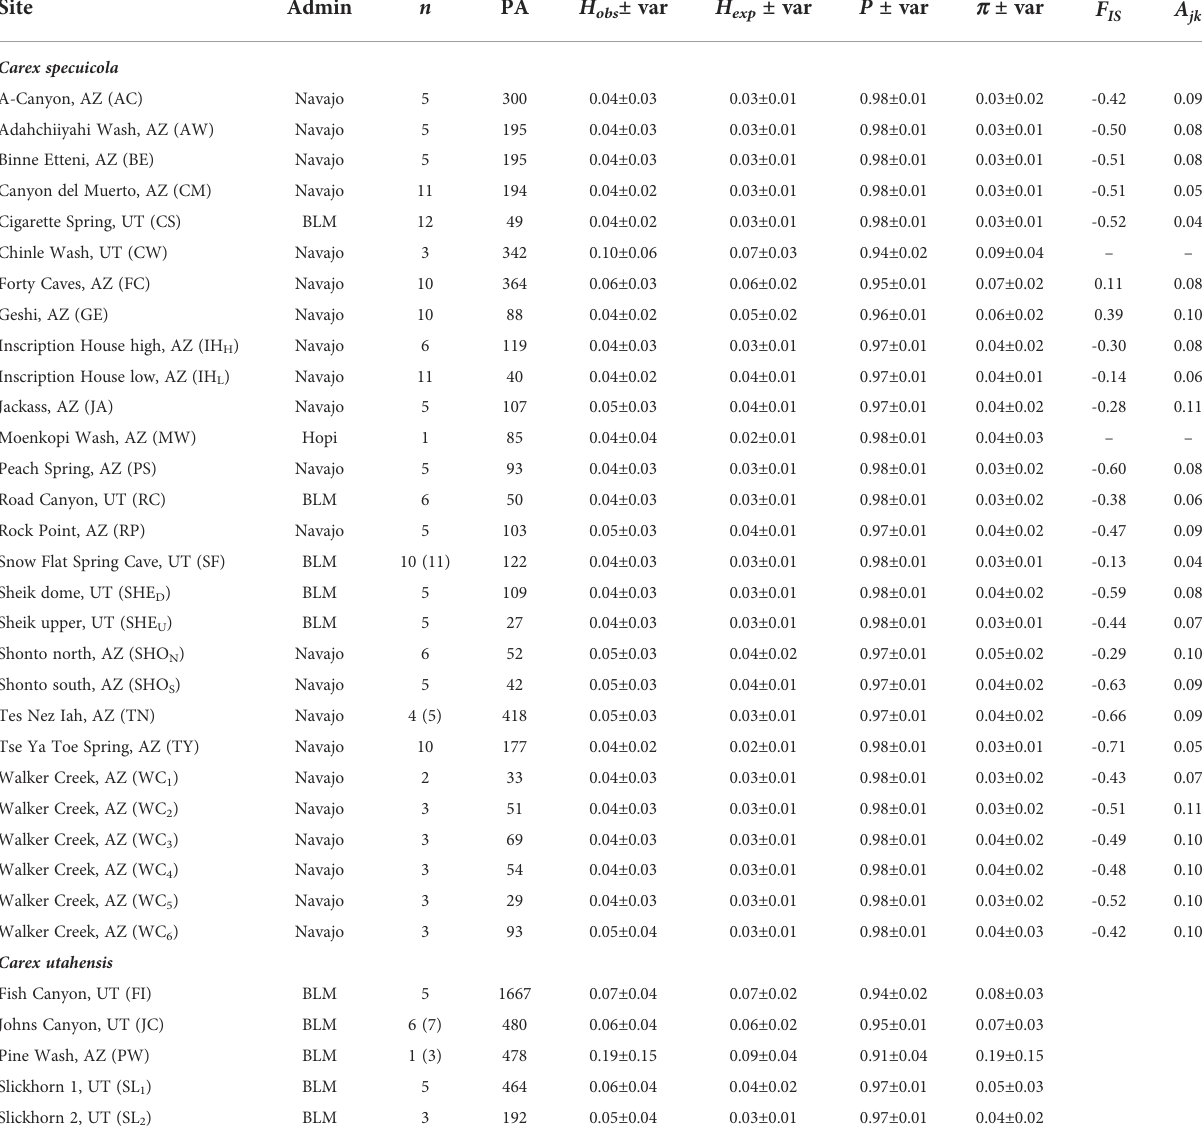
TABLE 1 Sampling site information for Carex specuicola and C. utahensis , including: Administrative unit (admin), sample size ( n ), private alleles (PA), observed and expected heterozygosity ( H obs , H exp ), major allele frequency ( P ), and nucleotide diversity ( p ). Site